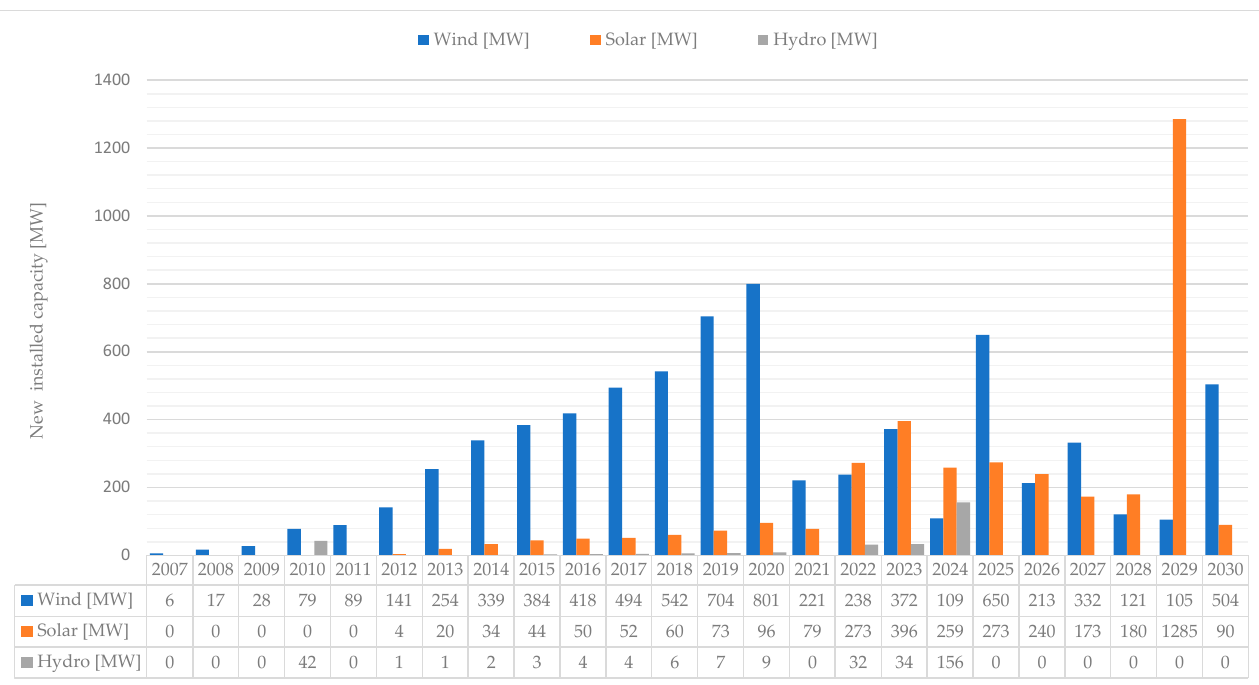
Figure 6. Total planned RES capacity in the period 2020–2030 yearly expected dynamics of capacity increase.